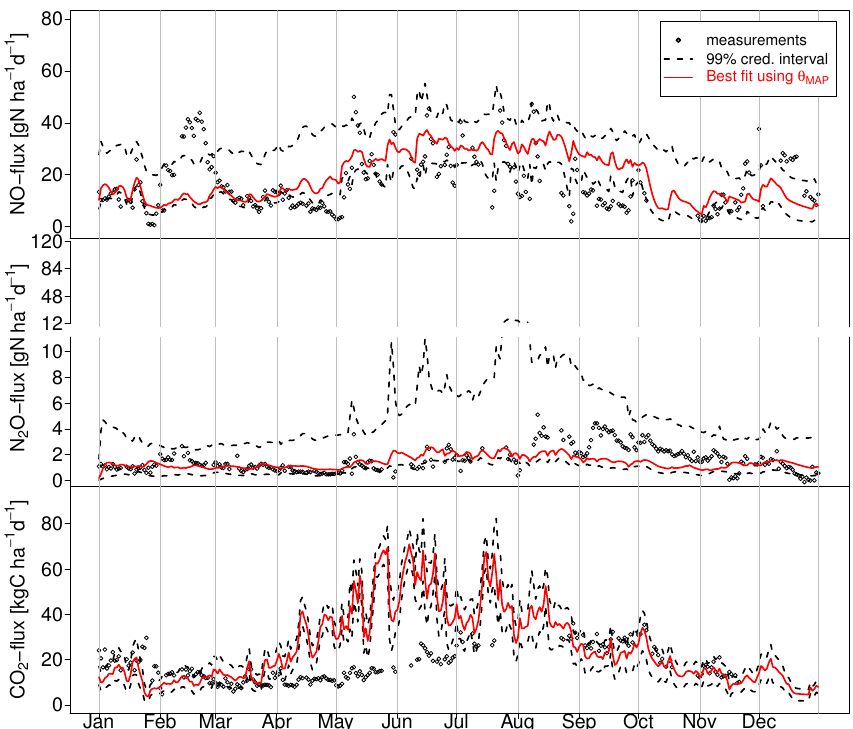
Fig. 7. Simulated fluxes (validation set) versus measurements of NO, N 2 O and CO 2 fluxes at the spruce site of the H¨oglwald forest in the year